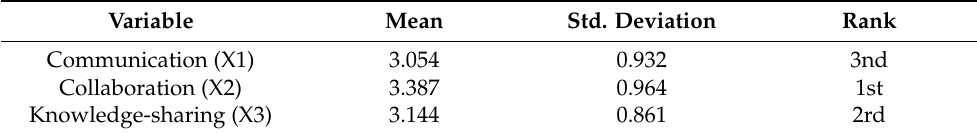
Table 4. Result of the overall value of mean and standard deviation for all stakeholders.